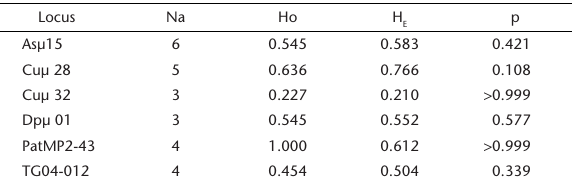
Table 2. Number of alleles per locus (Na), observed (Ho), and expected (He) heterozigosities, and probability for heterozygote deficit